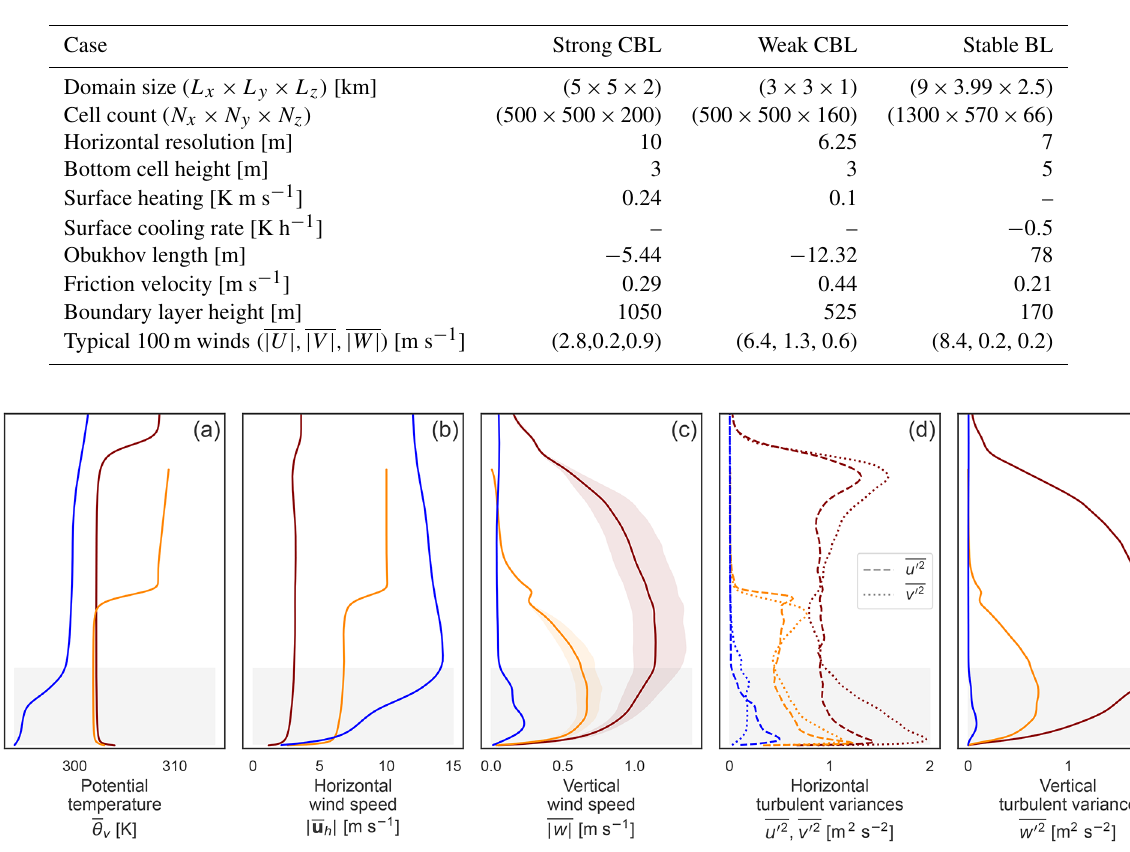
Table 2. Parameters for WRF-LES runs used to represent different stability regimes.